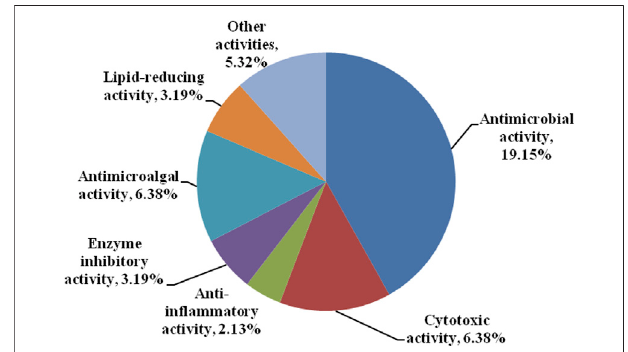
FIGURE 9 | Bioactivity categories of the reported